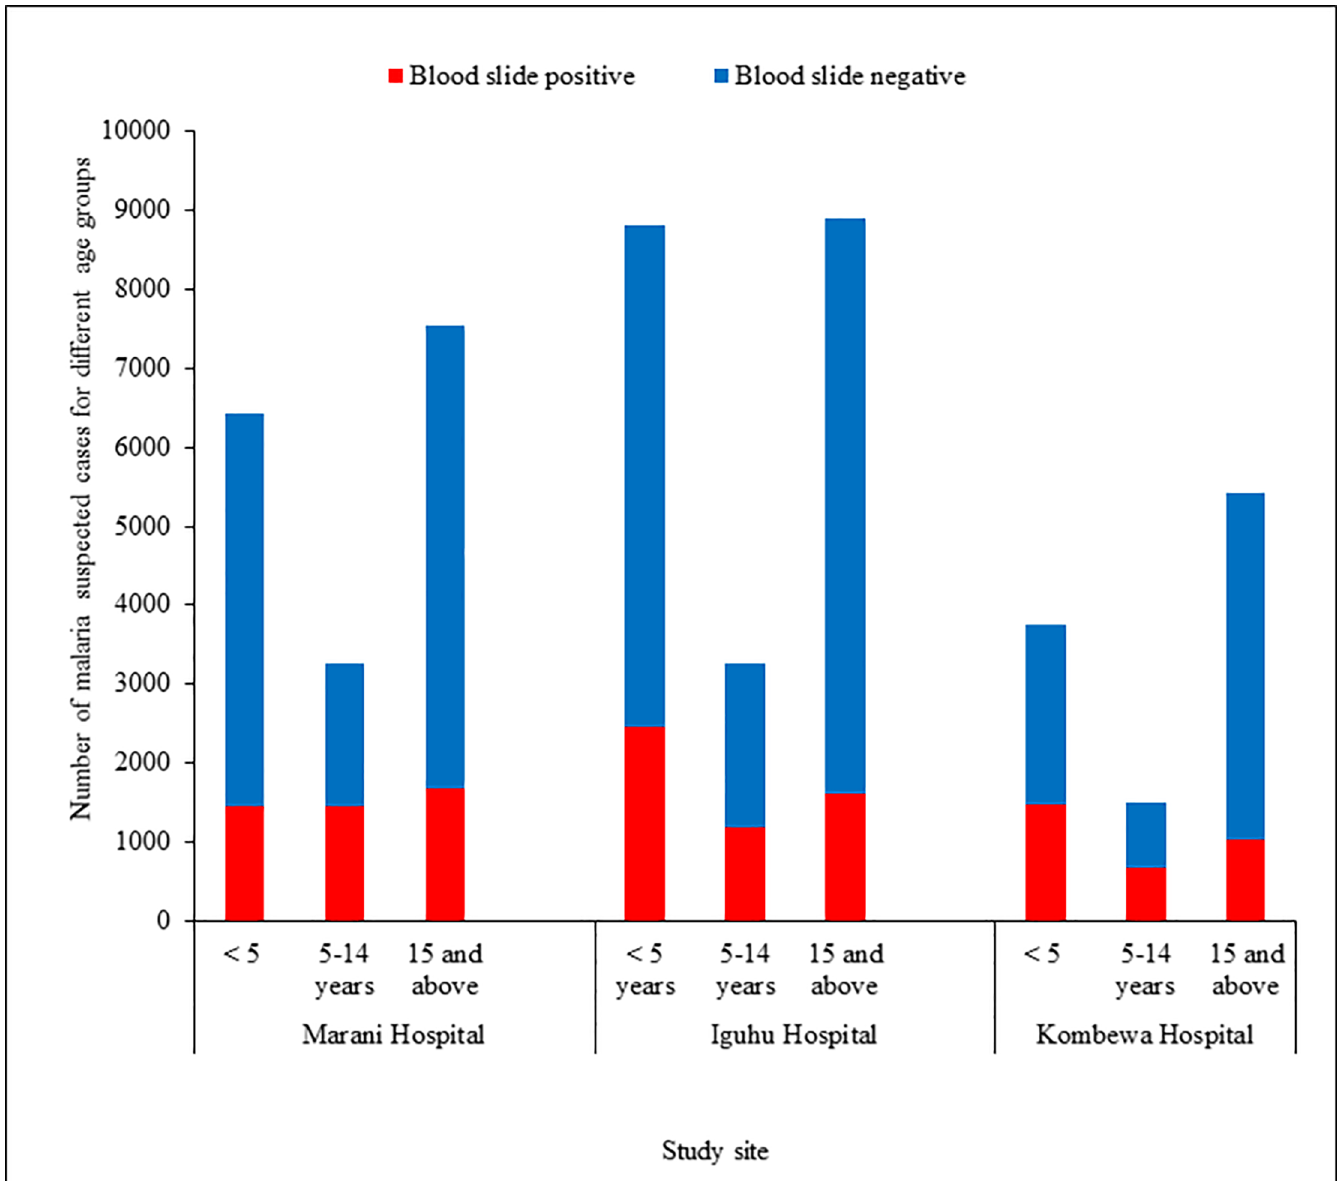
Fig 2. Total blood slide confirmed malaria cases among suspected patients attending outpatient departments from three hospitals located in different transmission settings of Western Kenya from June 2015 to August